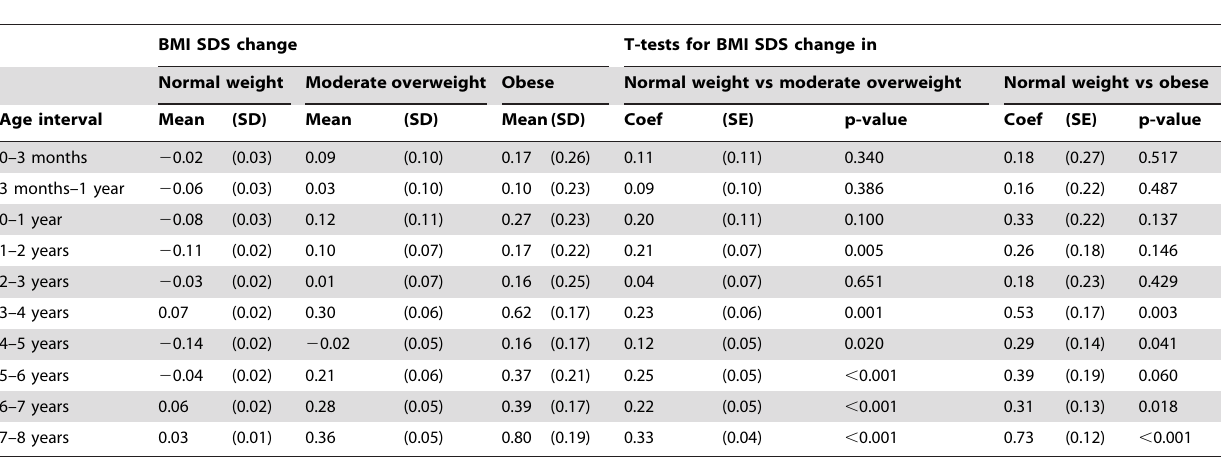
Table 3. Mean (SD) BMI SDS change during consecutive 1-year-age intervals for normal weight, moderate overweight and obese children at age 8 as well as results of t-test on the difference in change between these groups during these age intervals.